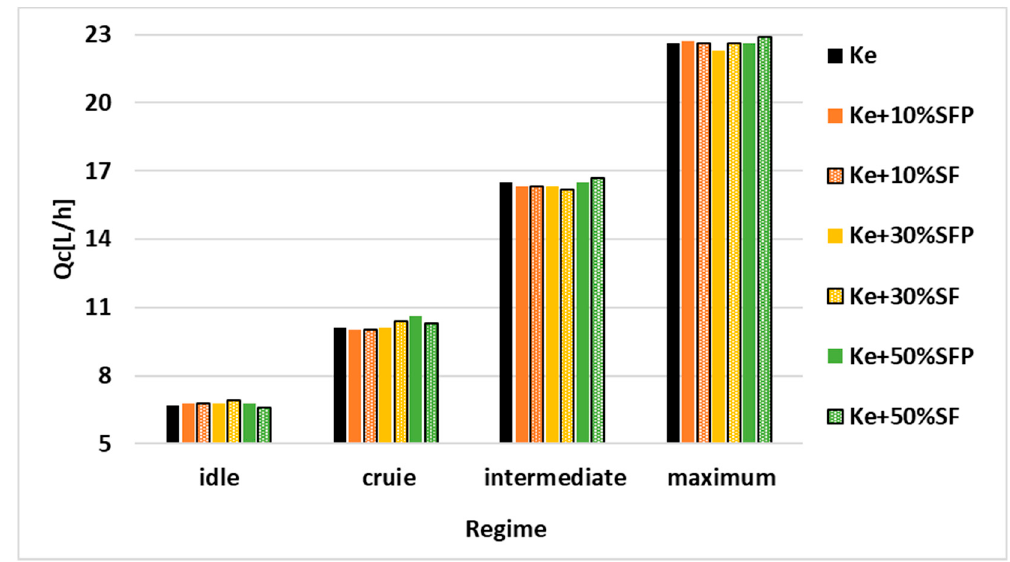
Figure 7. Variation of Qc (L/h) depending on the regime and blends.